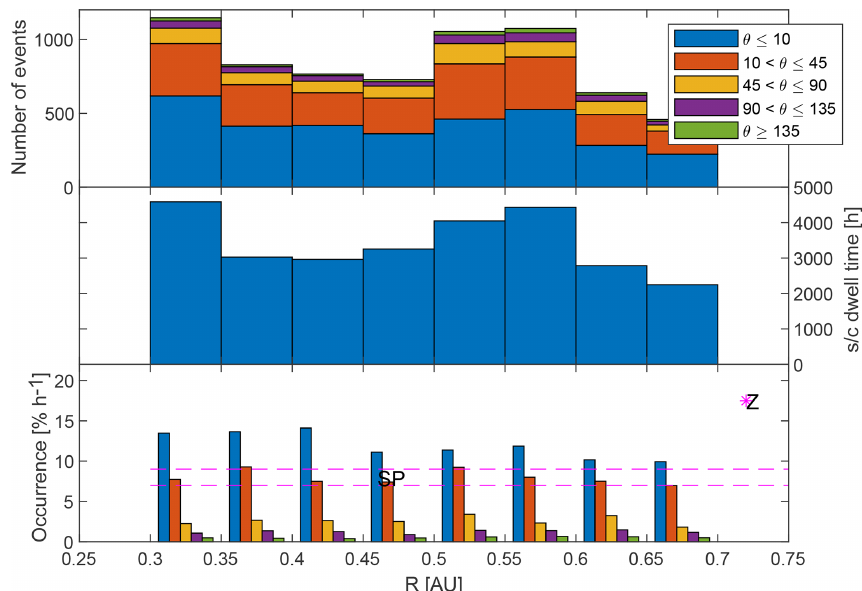
Figure 6. Histogram of the occurrence rate of MHs as a function of radial distance and colour coded after the rotational bins as given in the legend. For each category the single count statistical error is determined and plotted as an error bar. The magenta asterisks in the bottom panel show the occurrence rate near Venus (Zhang et al., 2008, Z). The two dashed magenta lines are the average Helios occurrence rate (Sperveslage et al., 2000, SP).